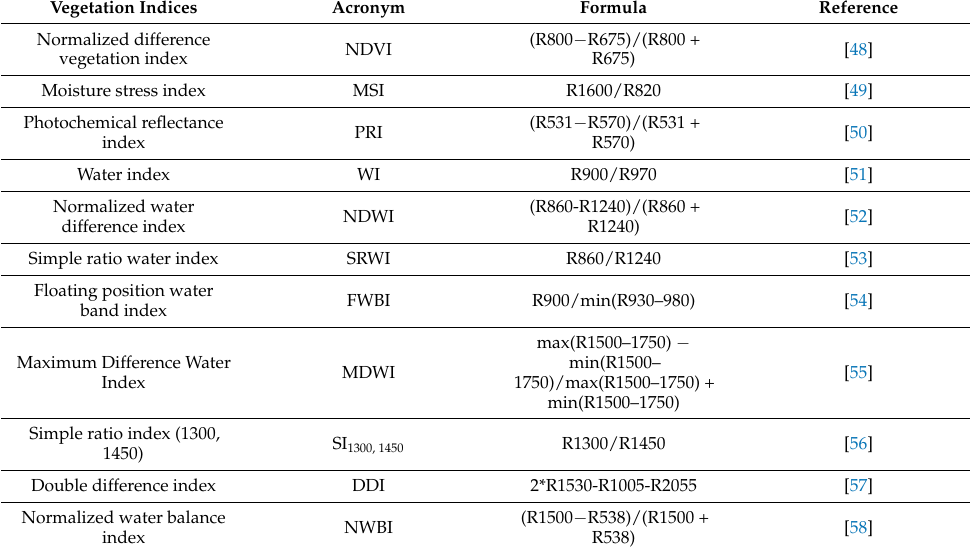
Table 3. Vegetation indices used in this